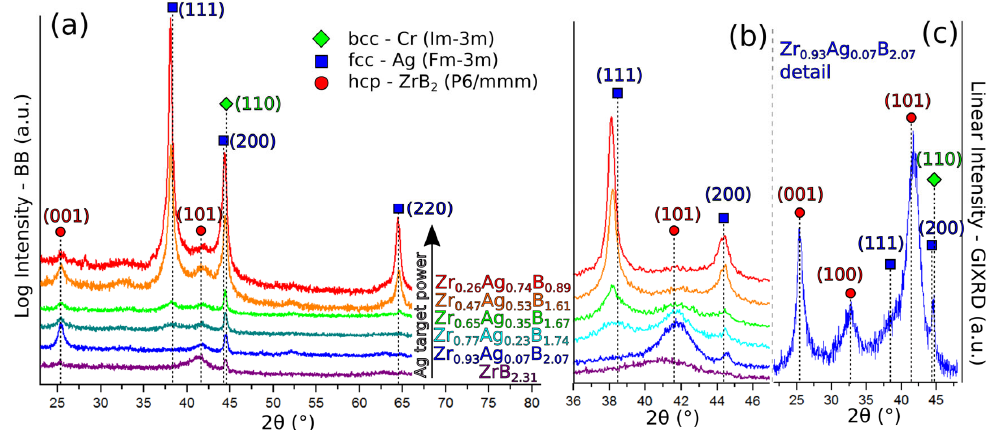
Figure 3. ( a ) Bragg–Brentano XRD patterns of reference ZrB 2+ ∆ and Zr 1 − x Ag x B 2+ ∆ films, ( b ) grazing incidence XRD detail on selected reflections indicating presence of segregated Ag phase even at 2 at.% of Ag content, and ( c ) grazing incidence XRD detail Zr 0.93 Ag 0.07 B 2.07 pointing out at the presence of (111) Ag